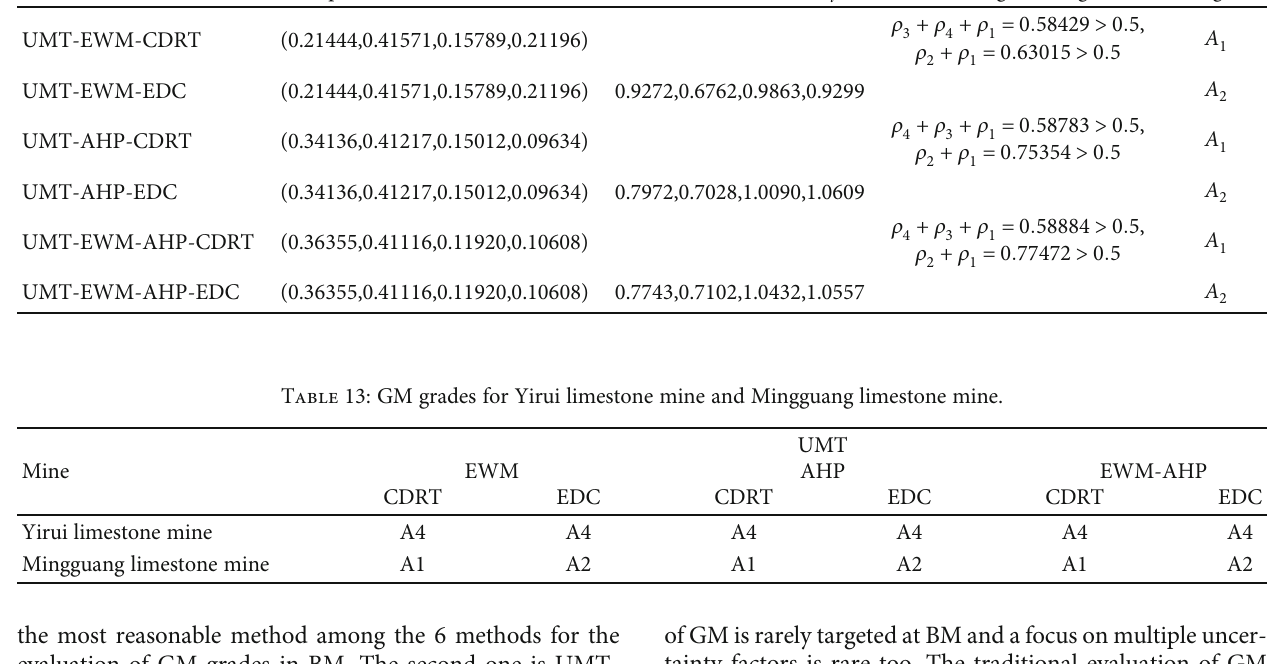
Table 12: Evaluating indicators, Euclidean distances, credible degree recognitions, and GM grades for Mingguang limestone mine. Method